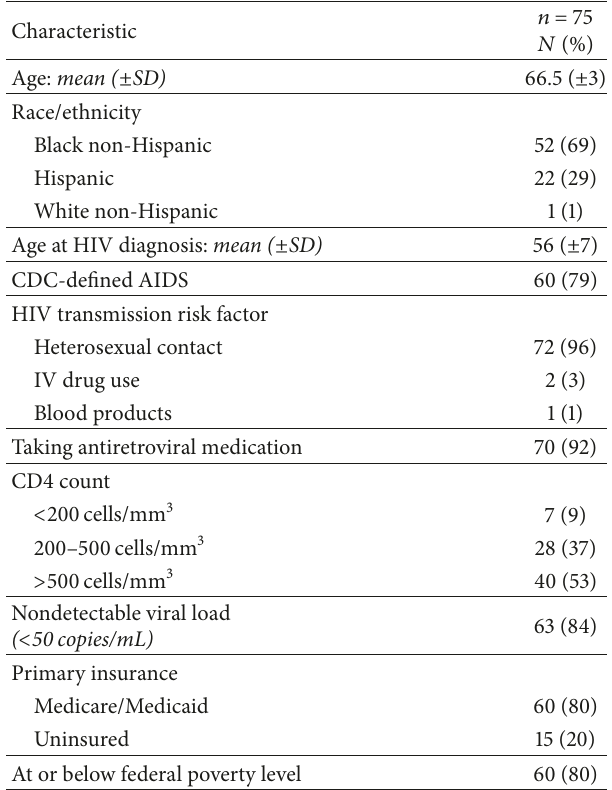
Table 1: Demographic characteristics of HIV+ women > 65 years old.